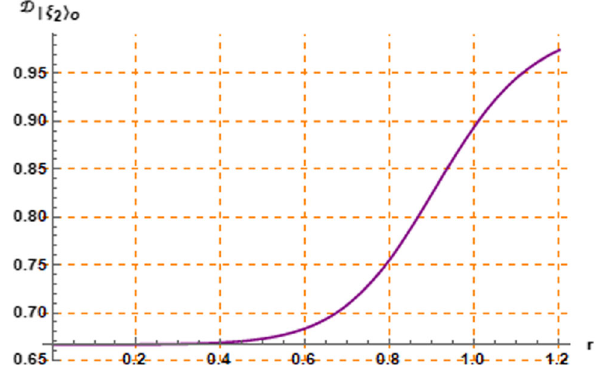
Fig. 7 Behaviour of D T | ξ choices of parameter p value as in Fig. 6. Note that D T | ξ when r (cid:10) 1, otherwise D T | ξ